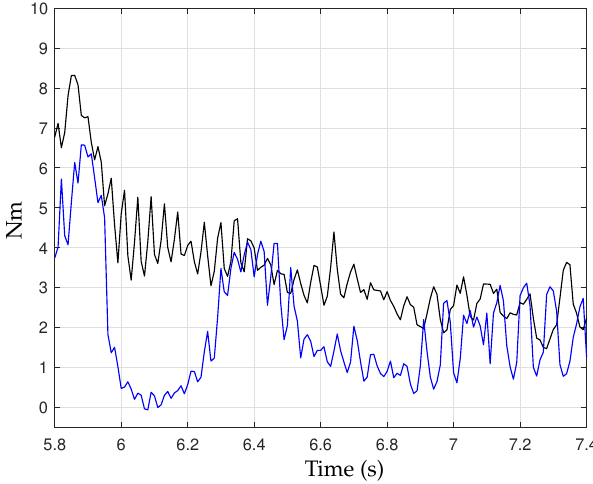
Figure 7. Braking torque T b applied to the ABS laboratory setup: a modified HOSM controller using PID-sliding surface (14) (black) or PID-like controller (26)